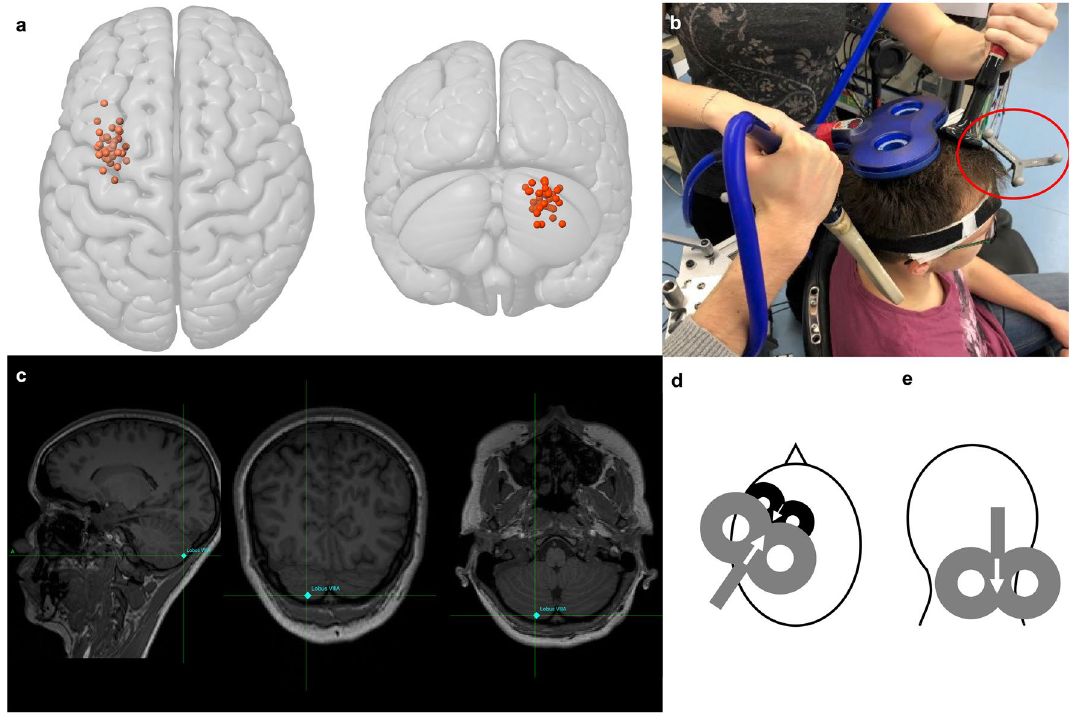
Figure 2. Coil positions and stimulation sites. ( a ) Individual stimulation sites for right lobule VIIIA (red) and dorsal premotor cortex (PMd) (orange) using the Montreal Neurological Institute and Hospital (MNI) stimulation coordinates in anatomical convention. ( b ) Neuronavigated triple-coil transcranial magnetic stimulation (TMS) experimental setup. The red circle marks the position of the tracer with three reflecting spheres on the subject’s head (staff member, that gave permission to publish the picture). TMS coils are located over PMd (small 25 mm black coil) and cerebellum stimulation site (grey figure of eight coil). Blue 70 mm coil is located over the primary motor cortex (M1) hot spot. ( c ) Magnetic resonance T1-weighted image (MRI) of one participant with targeted stimulation spot in the right lobule VIIIA at the cerebellar surface using radiological convention. ( d ) View from above. The black coil symbolizes the 25 mm branding-iron-coil positioned over the left PMd. White arrow indicates TMS current flow in anterior-to-posterior direction. Grey coil symbolized 70 mm coil positioned over M1 and slightly overlapping with PMd coil. White arrow indicates TMS current flow in posterior-to-anterior direction. ( e ) View from behind. The grey coil symbolizes the 70 mm coil positioned over the cerebellum (lobus VIIIA) with handle pointing